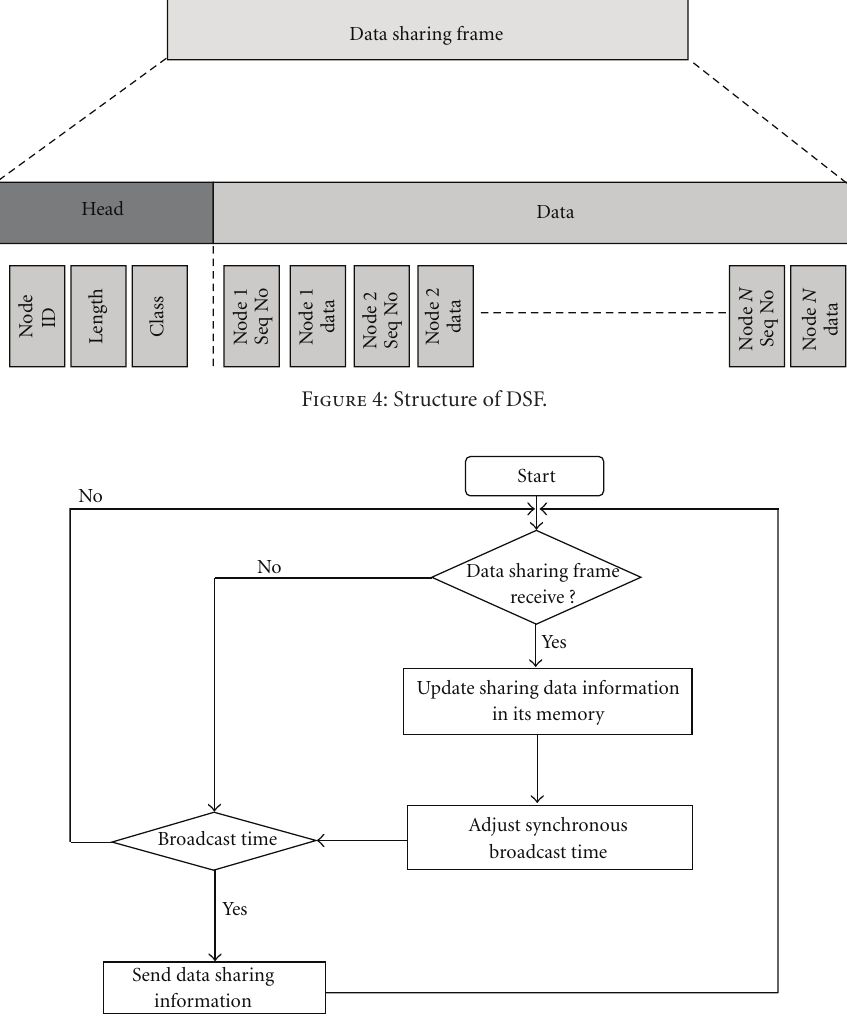
Figure 5: Flow chart of software structure in each WSN